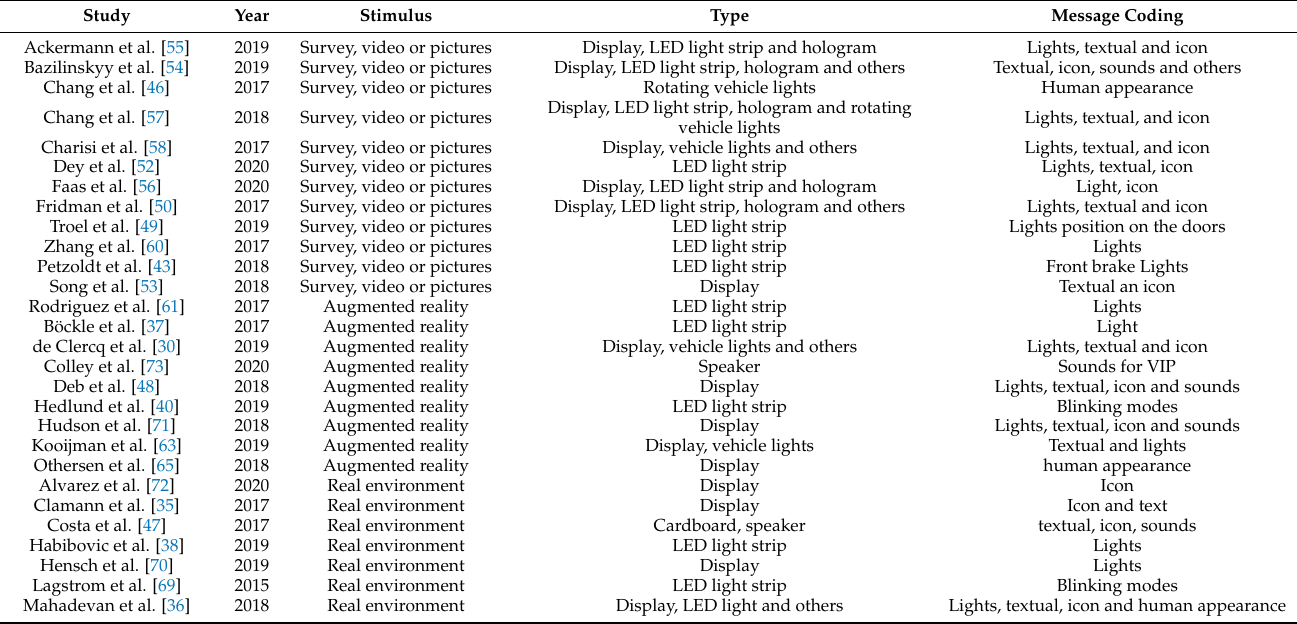
Table 2. List of all surveys of all experiments shown in this paper sorted by the experiment type, environment, and message coding method in alphabetic